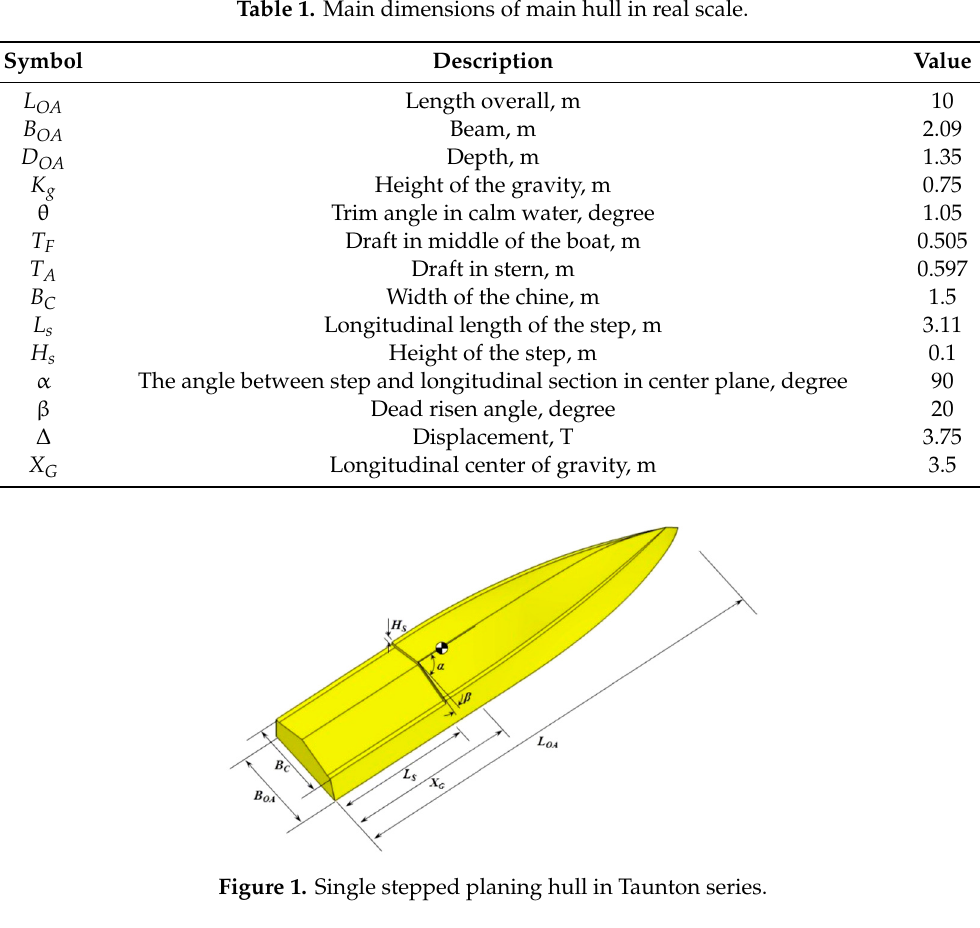
Table 1. Main dimensions of main hull in real scale.